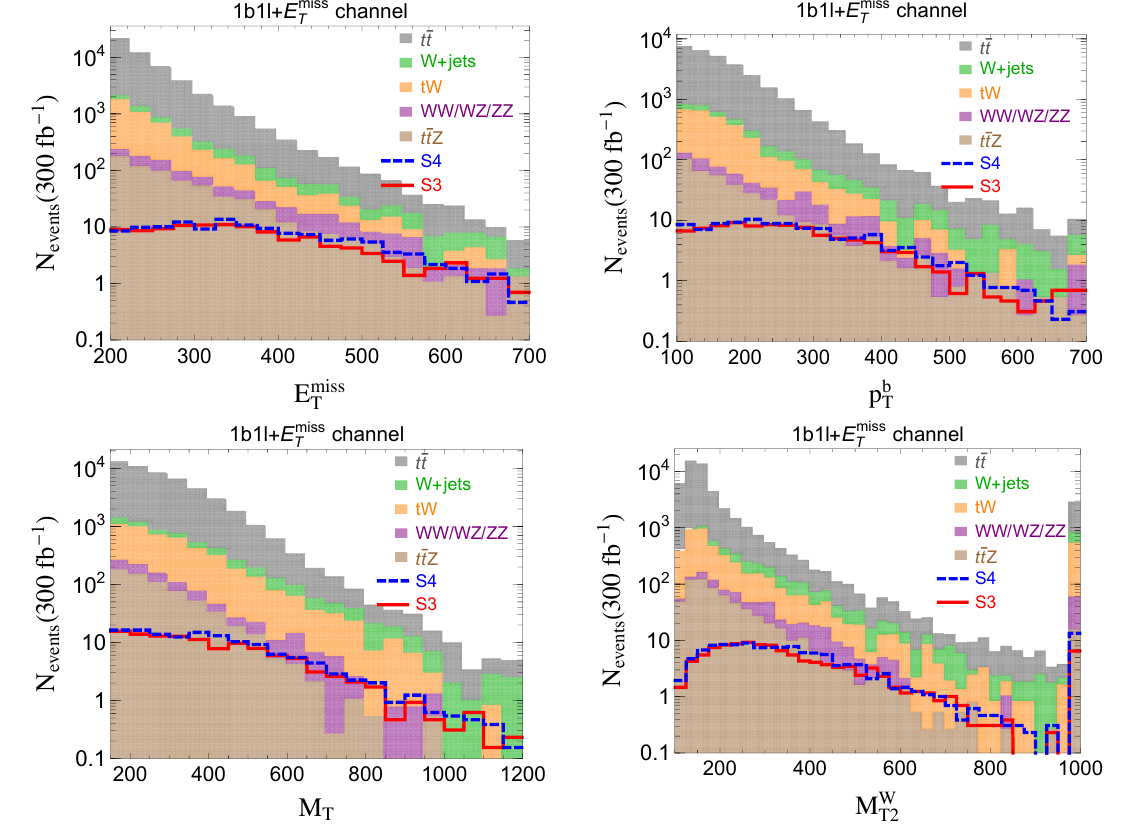
Figure 4 . Distributions of E miss right ) of the 1 b 1 ‘ + E miss